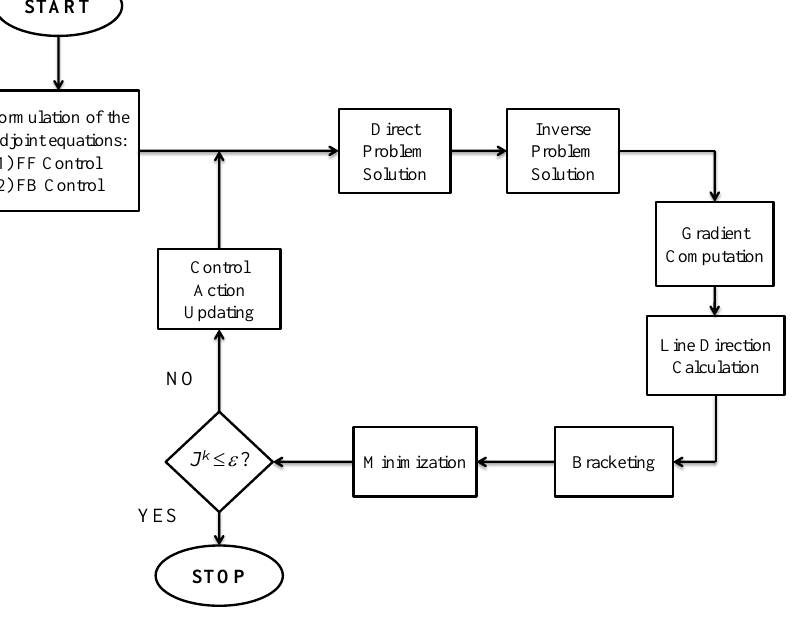
Figure 1. Adjoint iterative computational algorithm.